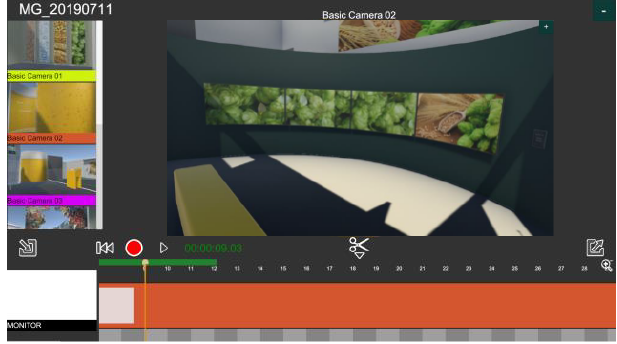
Figure 23. After a shot has been recorded, various editing functions can be accessed to produce the final